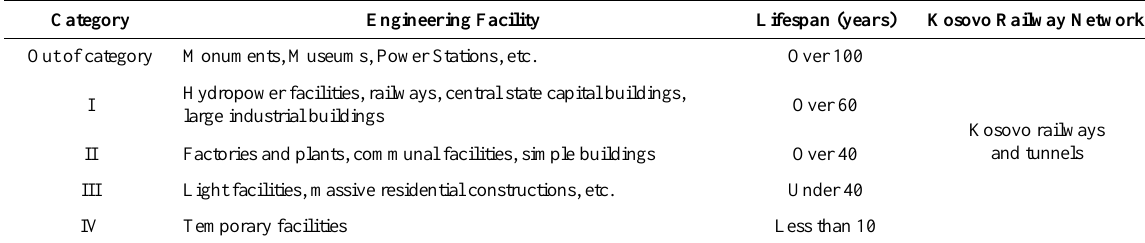
Table 2. Lifespan of construction engineering